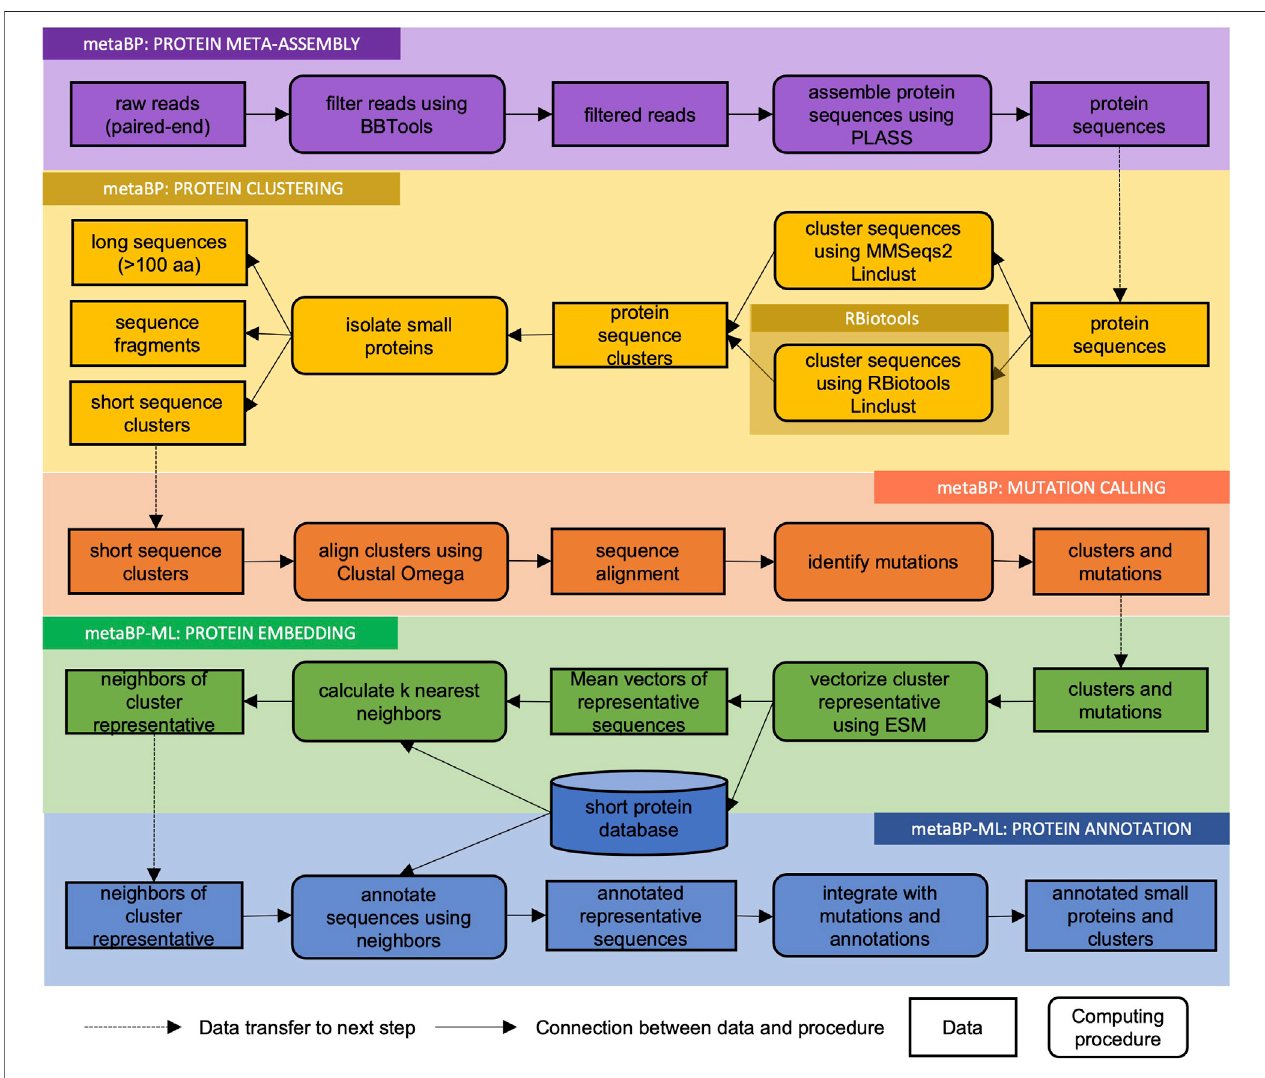
FIGURE 1 | Flowchart of metaBP pipeline. MetaBP ’ s implementation consists of three major modules (metaBP, metaBP-ML, and RBiotools), and fi ve main procedures (protein meta-assembly, protein clustering, mutation calling, protein embedding, and protein annotation).